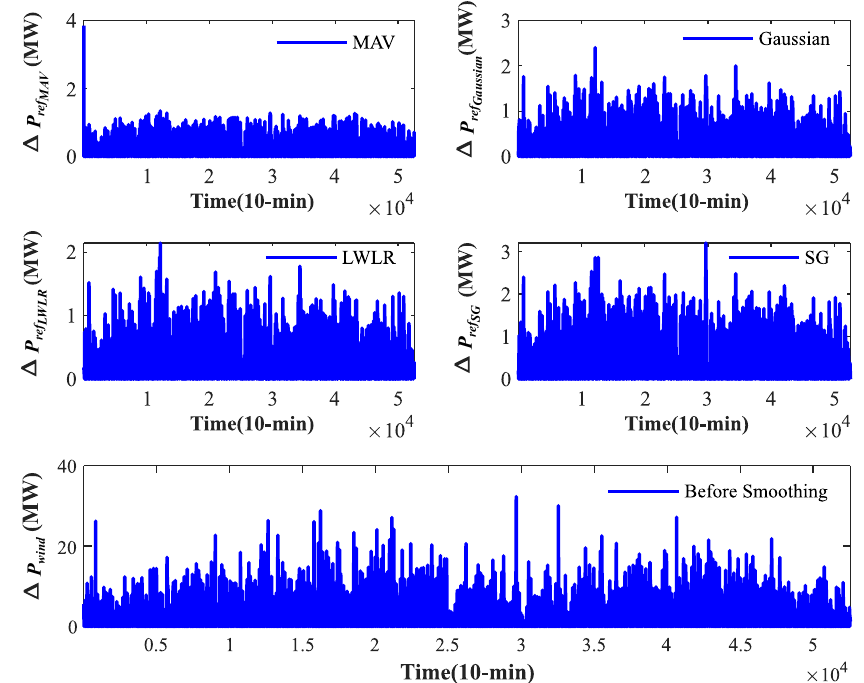
Figure 6. The yearly ramping rate of the wind farm. Each smoothing technique was used with 30 data points, and the generated P ref for each technique is shown in Figure 7. It is obvious that P ref is smoother than P wind . The purple-bounded regions in Figure 8 present how much P wind falls short of P ref . The gap between P wind and P ref is greater than that from other smoothing techniques. This MAV means more resources are needed to compensate the generations. As a result, a PV plant and BESS with 50 contribution factors (S) were installed to alleviate the shortfall, as stated in Section 2.